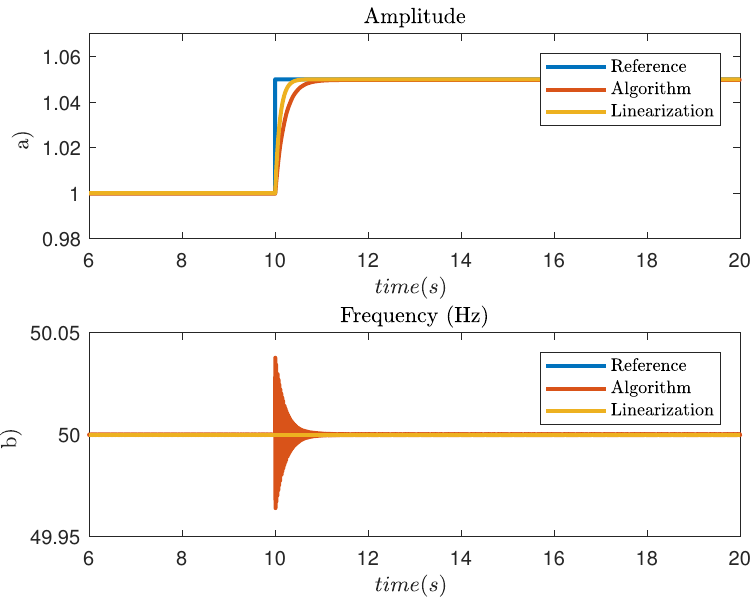
Figure 3. Amplitude tracking. ( a ) amplitude step; ( b ) frequency output of the algorithm.